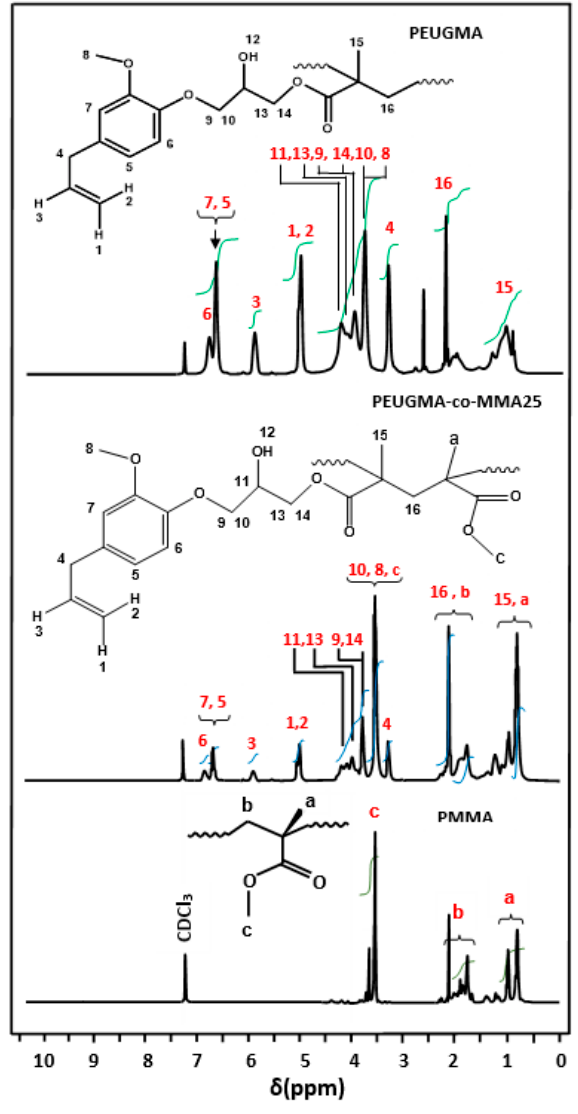
Figure 7. Comparative 1 HNMR spectra of PMMA, PEUGMA and PEUGMA-co-MMA25.